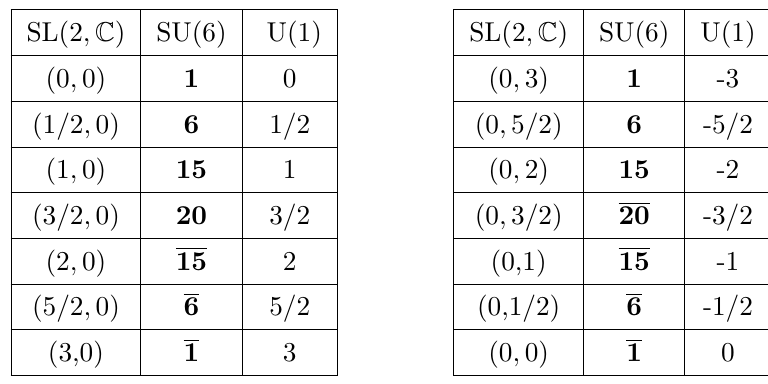
Table 5 . The irreducible chiral doubleton supermultiplets of SU(2 ; 2 j 6) and its conjugate, with the highest spin 3. Scalars here are singlets of SU(6). The vector (cid:12)eld strengths and their duals transform in 15 and (cid:22)15 of